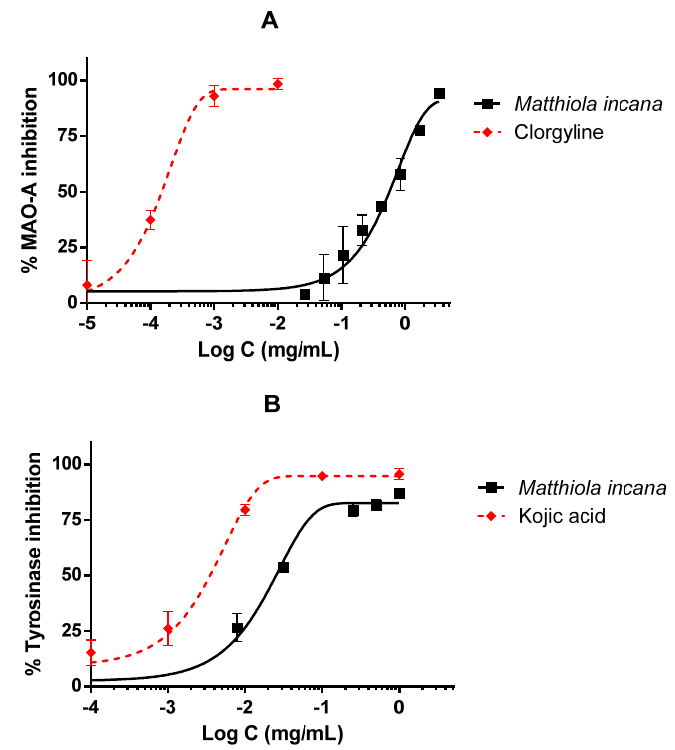
Figure 4. Activity of the hydroalcoholic extract of M. incana aerial parts in enzymes related to central nervous system (CNS) pathologies. IC 50 values were calculated by non-linear regression. All concentrations were tested at least in triplicate, and each point represents mean ± SEM. A: monoamine oxidase A (MAO-A) inhibition performed by M. incana extract and clorgyline as standard. B: